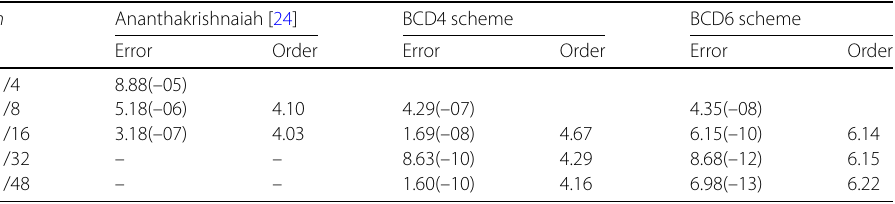
Table 3 The maximum error and convergence order for Problem 3